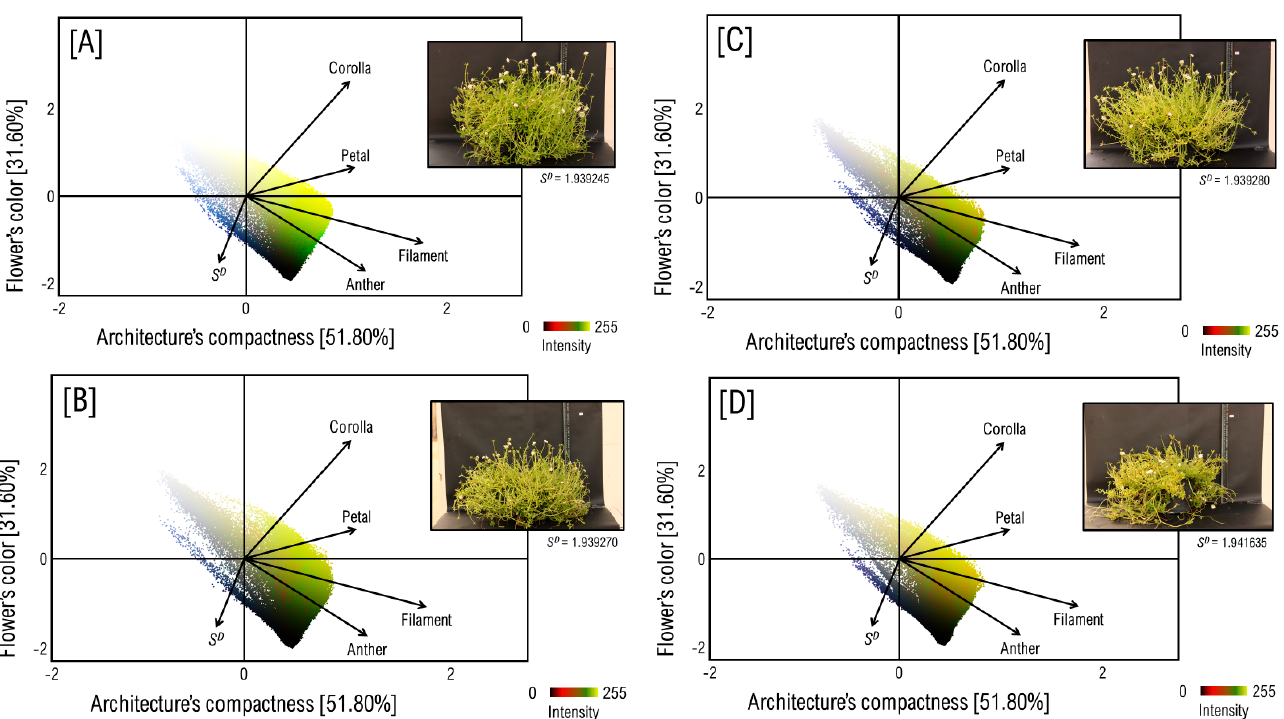
Figure 3. Mapping the botanical and computational features of flower and the architecture of white- flower samples of P. umbraticola . The sequence of alphanumerical symbols, from ( A – D ), relates to the increasing fractality of the pattern in the representation of the digital image.